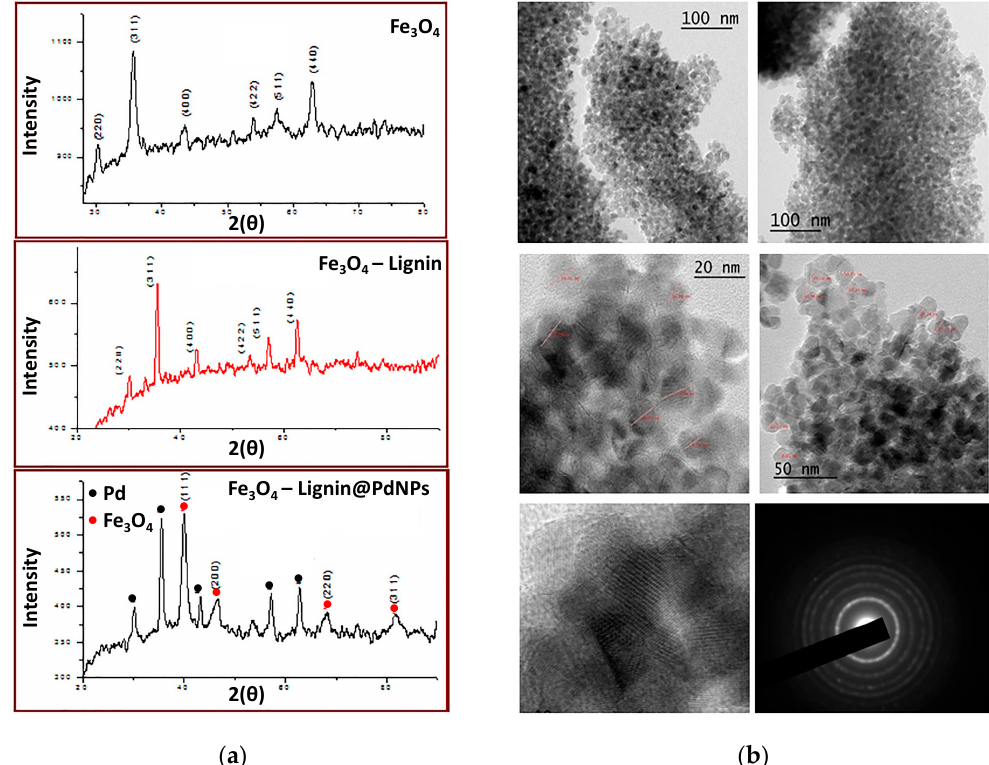
Figure 7. ( a ) XRD spectra of Fe 3 O 4 , LSA-Fe 3 O 4 NPs , and LSA-Fe 3 O 4 NPs-PdNPs . ( b ) TEM images at different scales for the obtained LSA-Fe 3 O 4 NPs-PdNPs catalyst. Adapted with permission from reference [80]. Copyright 2020 John Wiley and Sons